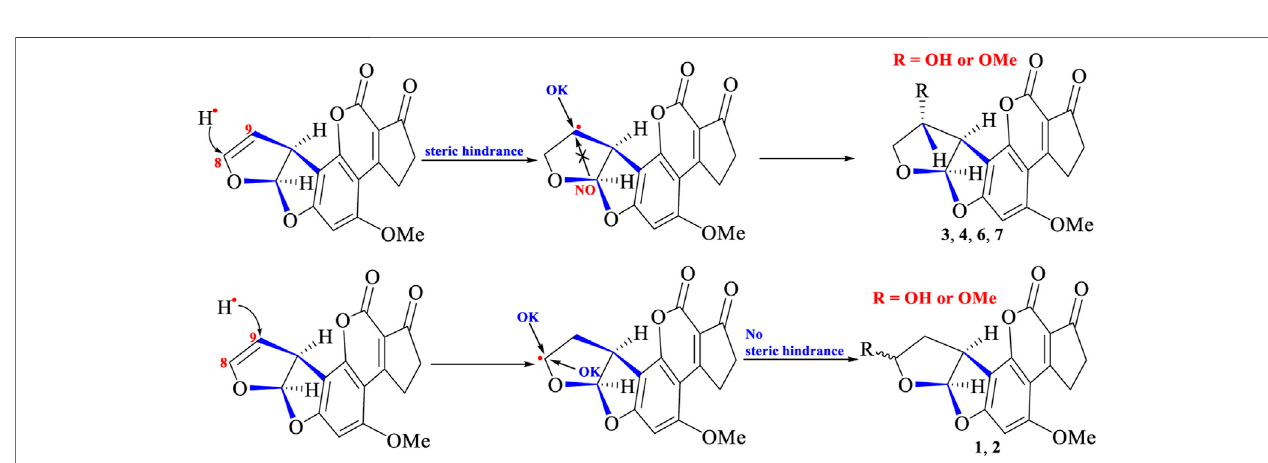
FIGURE 7 | Possible catalytic reaction happened at C-8 and C-9